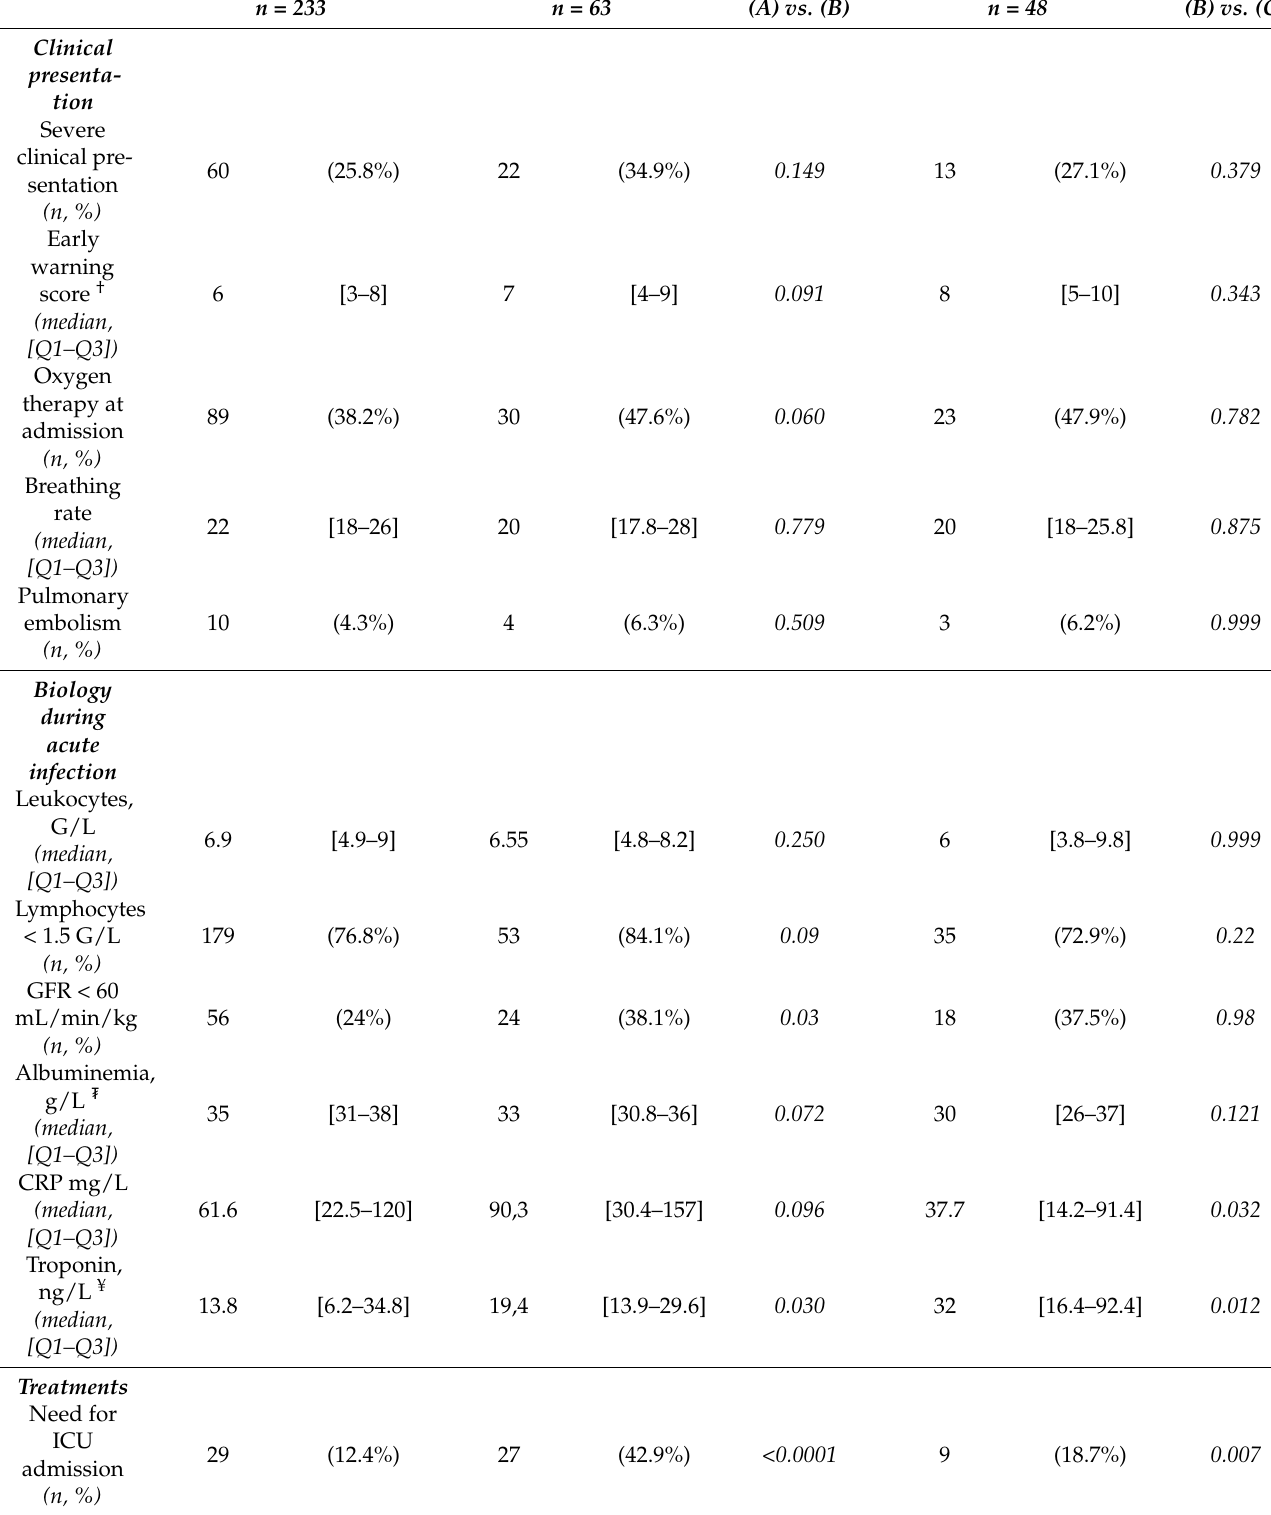
Table 1. Characteristics of patients according to discharge destination (PRM, PRU, home).